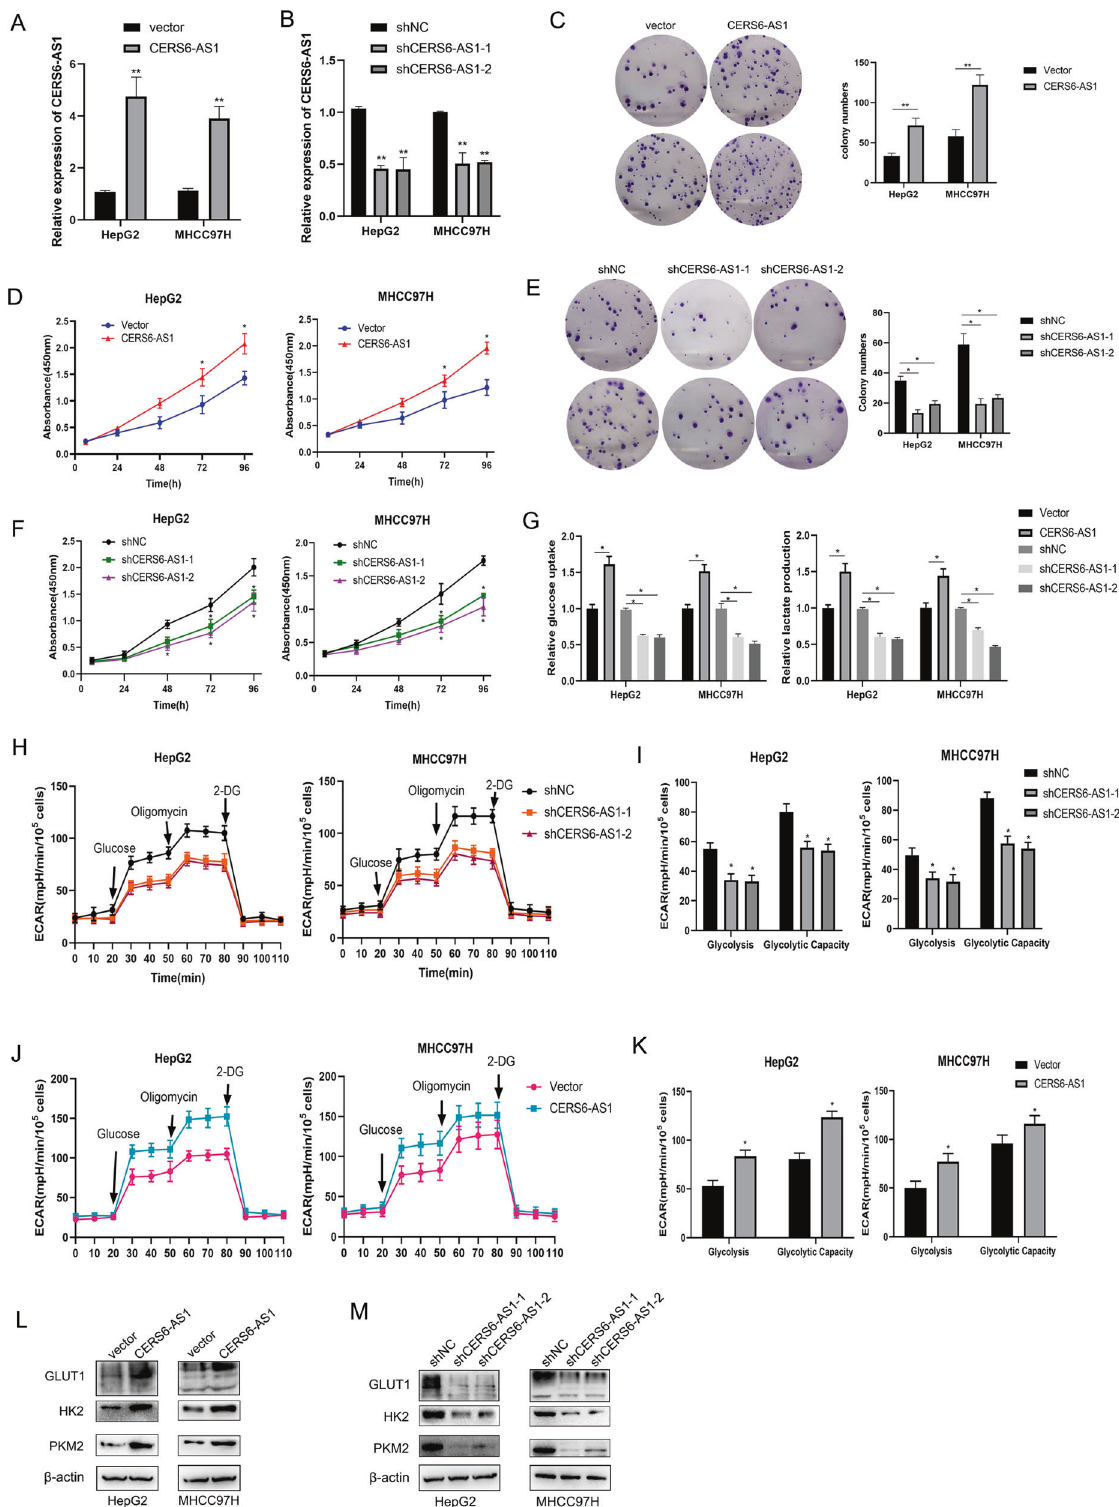
Fig. 2 LncRNA CERS6-AS1 facilitates HCC cell proliferation and aerobic glycolysis. A , B The qRT-PCR analysis was utilized to measure the transfection ef fi ciency in HepG2 and MHCC97H with CERS6-AS1 overexpression or knockdown sequence. Colony formation assays ( C , E ) and CCK-8 assays ( D , F ) were used to evaluate the proliferated ability in CERS6-AS1 overexpression or knockdown groups, respectively. G The relative glucose uptake or lactate production in CERS6-AS1 overexpression or knockdown groups. H , J ECAR of HepG2 or MHCC97H cells in CERS6-AS1 overexpression and knockdown groups were measured by a Seahorse Bioscience XFp analyzer. 2-DG 2-deoxy-d-glucose. I , K The statistical chart based on ECAR curve. L , M The key glycolysis proteins were detected in CERS6-AS1 overexpression or knockdown groups via western blot. All experiments included were repeated at least three times, * p < 0.05, ** p < 0.01.